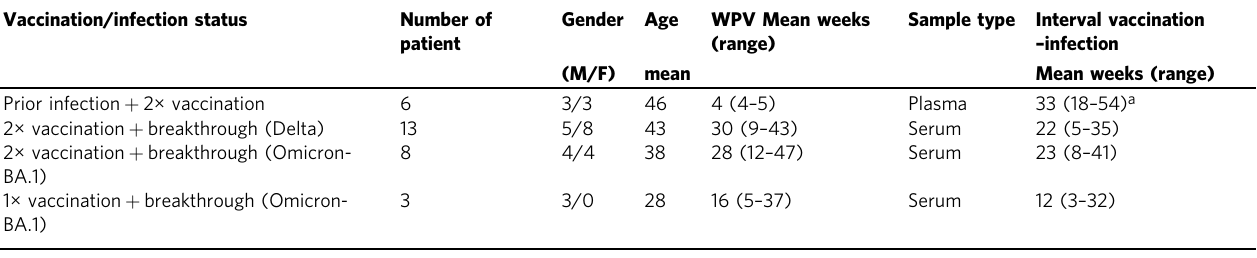
Table 3 Characteristic of vaccinated and infected individuals ’ samples.